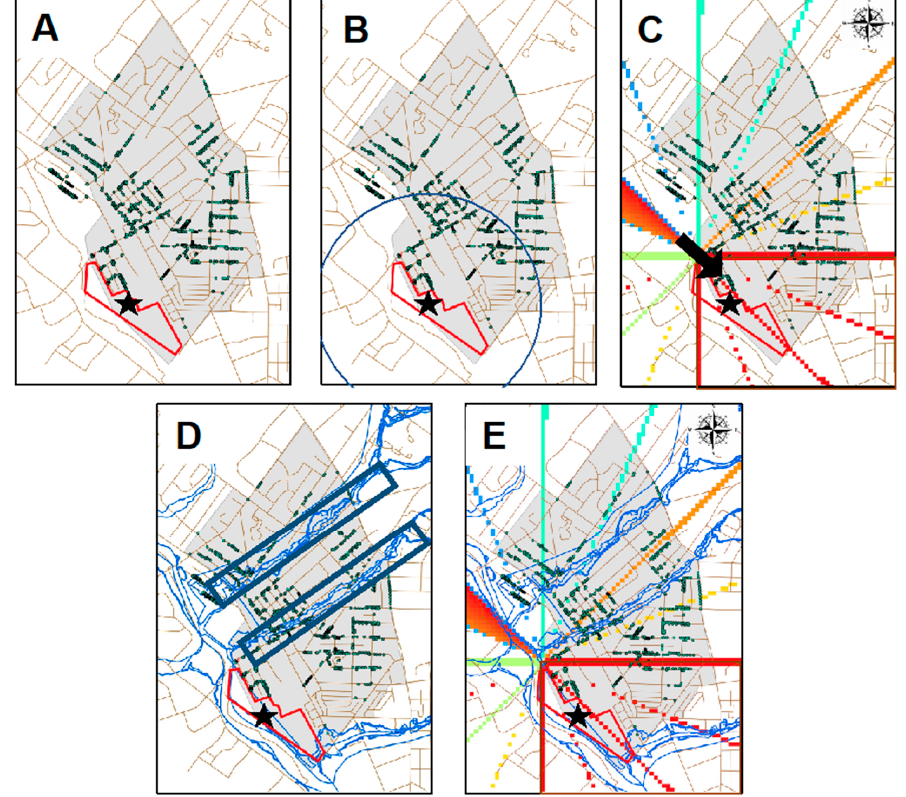
Figure 2. Outline of geospatial methods to identify subjects and classify exposure. ( A ). The digitized Ambler map with the highlighted South Ambler Piles indicated by the red boundary and star, the grey area represents the Ambler township and each green dot represents a member of the cohort. ( B ). A representation of the techniques used in ArcMAP to stratify the cohort by distance. ( C ). A wind-rose established by historic records acquired from the National Ocean and Atmosphere Association was applied to the cohort; a SE prevalence wind was found, thus the SE members of the cohort were classified as downwind of the Ambler Piles. ( D ). The Federal Emergency Management Agency (FEMA) National Flood Hazards Layer within the Ambler township was overlaid and those members of the population within those flood zones were selected. ( E ). A subgroup of individuals (demarked by the magenta area) was selected to represent a portion of the cohort who experienced a concentrated amount of environmental asbestos exposure by being both in close proximity and downwind of the piles.